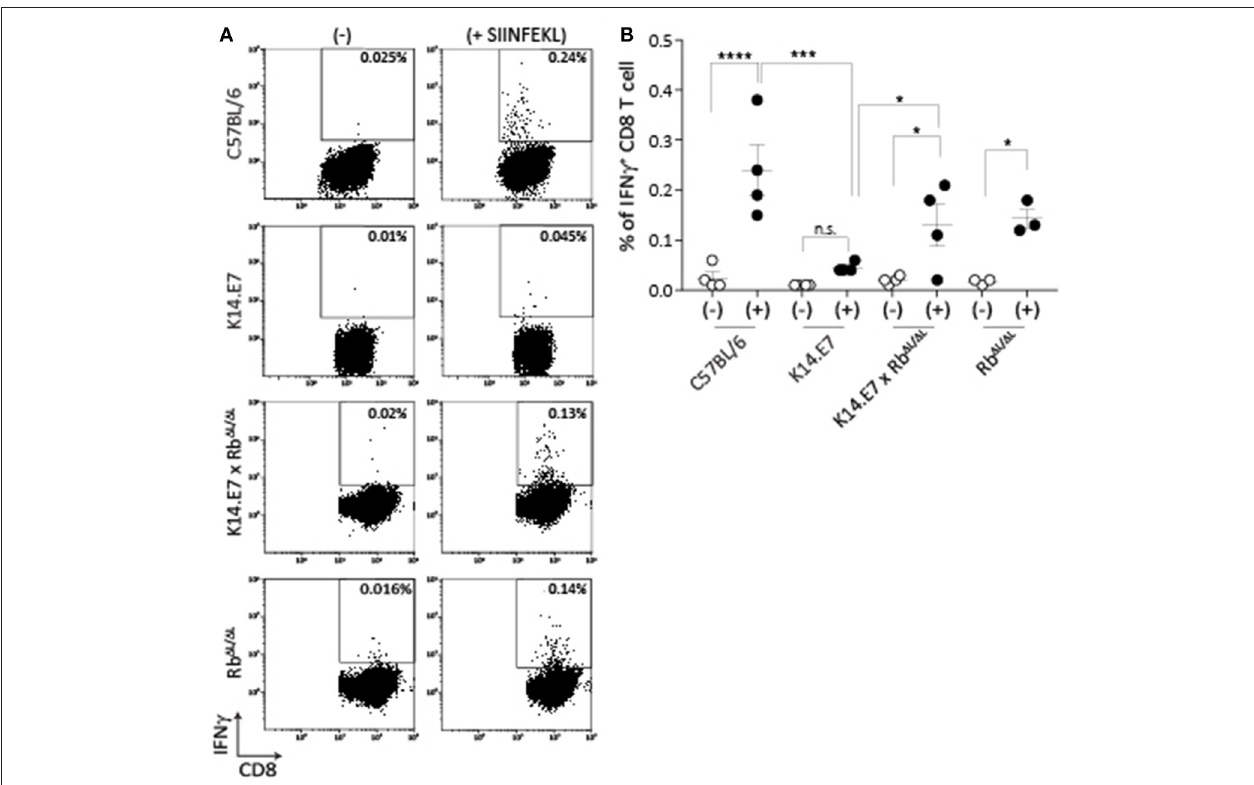
FIGURE 1 | K14.E7xRb 1 L /1 L and non-transgenic mice respond equally to intradermal immunization. OVA specific CD8T cell responses in the draining LN following intradermal immunization were assessed as IFN γ production following in vitro peptide re-stimulation. (A) Representative FACS plots pre-gated on TCR β + CD8T cells showing IFN γ production with ( + ) or without (-) SIINFEKL re-stimulation. (B) Quantitative result showing mean ± SEM with n > 3 for each mouse type. Open circle, without stimulation; closed circle, with stimulation. Analyses were done using one-way ANOVA, with Bonferroni’s multiple comparison tests. Result significance was shown, where * p < 0.05, *** p < 0.001, and **** p <